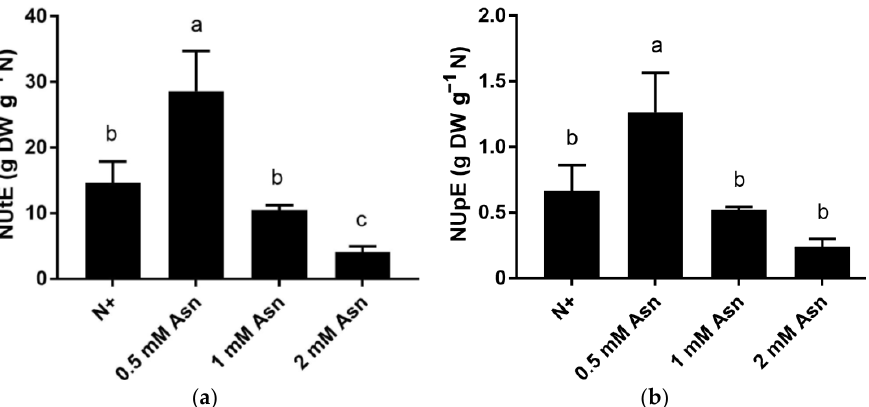
Figure 3. Effects of exogenous asparagine (Asn) on the nitrogen (N) and carbon (C) contents in the shoots and roots of poplar ‘Nanlin89 5 ’ . ( a ) total N content; ( b ) total C content; ( c ) the C/N ratio. “N0” indicates N- free reference; “N+” represents the inorganic N control. The concentra tion of Asn ap- plied was 0.5 mM, 1 mM, and 2 mM as indicated. Bars denote means ± SD (n ≥ 3), and different letters indicate significant differences ( p < 0.05) based on Duncan’s test.